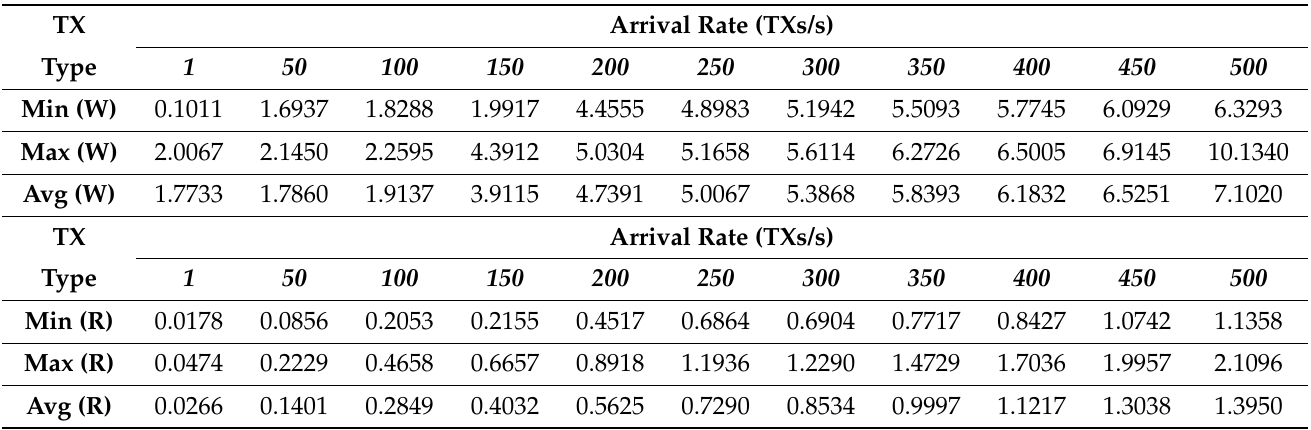
Table 3. Latency measures, in seconds, for read (R) and write (W) TXs in a local Docker environment where network size = 4.